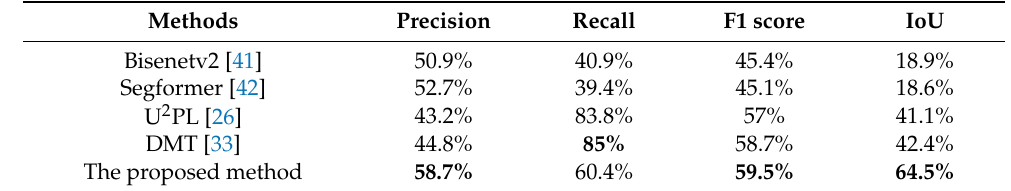
Table 1. Quantitative evaluation results of Experiment 1. The entries in bold denote the best results in Experiment